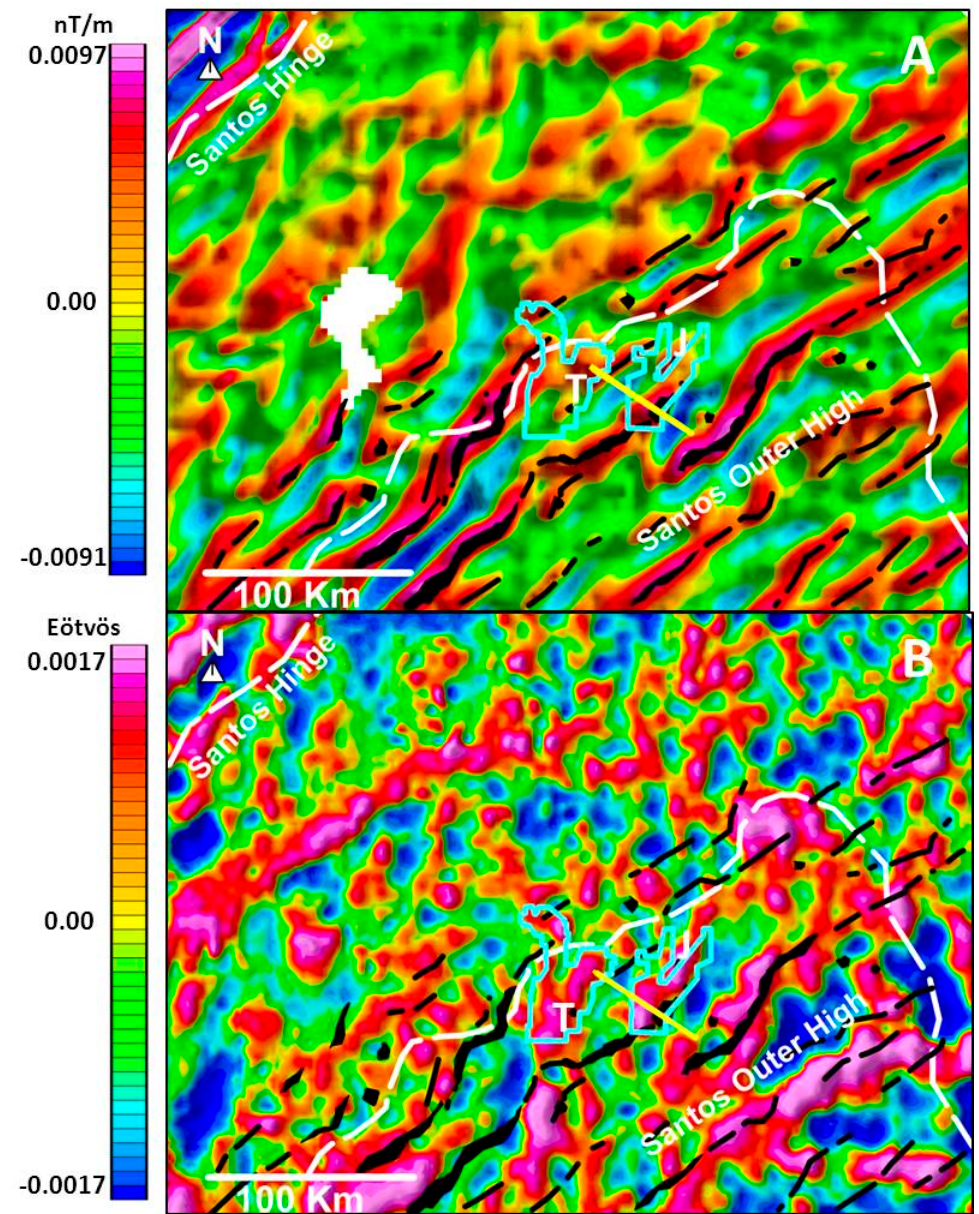
Figure 6. Interpretation map of the detail area highlighted in the Figures 4 and 5. ( A ) Magnetic map of derivative showing interpreted magmatic bodies injected in the crust, represented by black areas and black dashed lines, associated with axes of maximum values of the derivative (areas in warm tones). Observed declination and inclination of the total magnetic field (D = 23° W, I = − 42°). ( B ) Residual Bouguer map showing the injected magmatic bodies underlying the basement structural highs (red and pink areas). The blue polygons indicate the areas of Tupi (T) and Jupiter (J) associated with their respective structural highs. The yellow straight line shows the location of the modeled section shown in Figure 7.